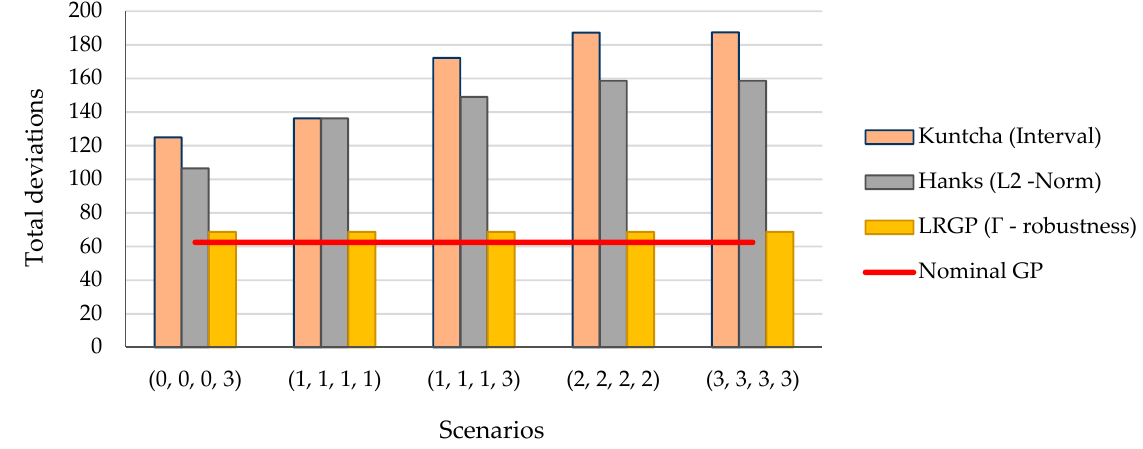
Figure 1. Comparison of total goal deviations .